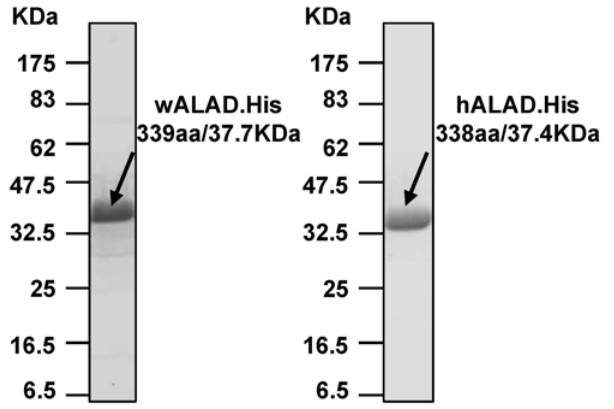
Figure 4. Purification profiles for C-terminally 6XHis-tagged wALAD and hALAD recombinant proteins.